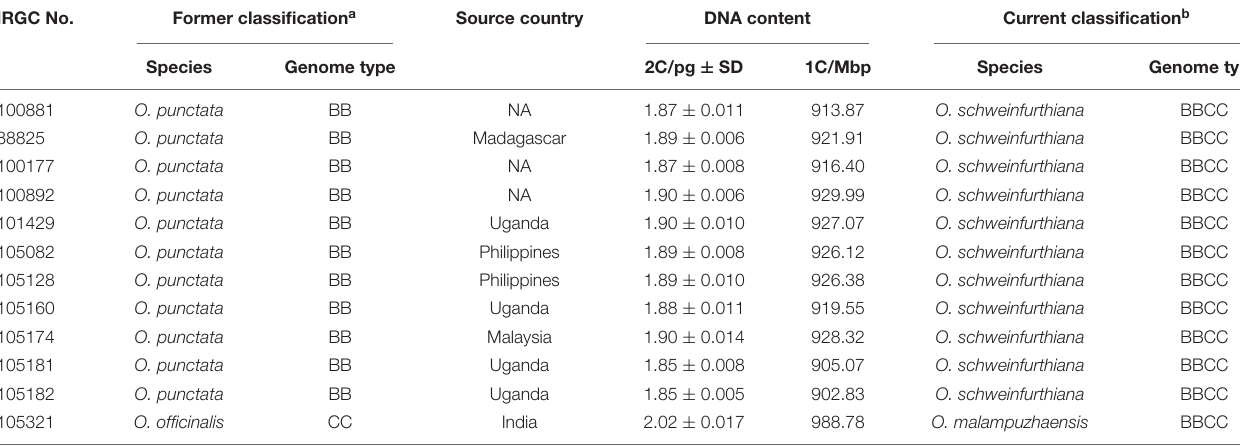
TABLE 3 | Reclassification of Oryza accessions based on flow cytometry analysis. IRGC